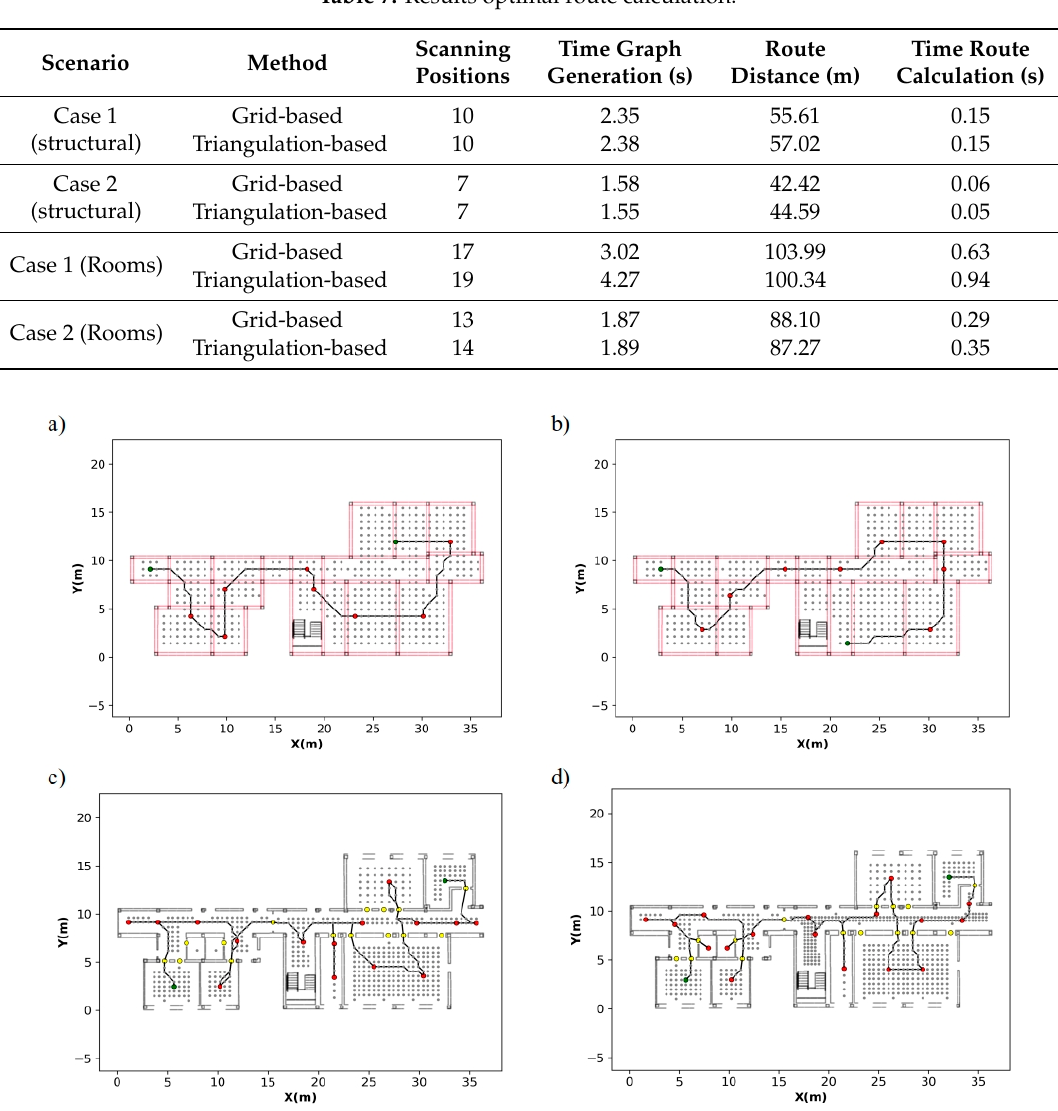
Figure 21. Optimal route calculated in case study 1 whose scanning positions were obtained by: ( a ) grid-based method in structural phase, ( b ) triangulation-based method in structural phase, ( c ) grid-based method with rooms and ( d ) triangulation-based method with rooms. Horizontal and vertical elements are displayed in magenta and black respectively. Green points represent start and end scanning position, the remaining ones are depicted in red.